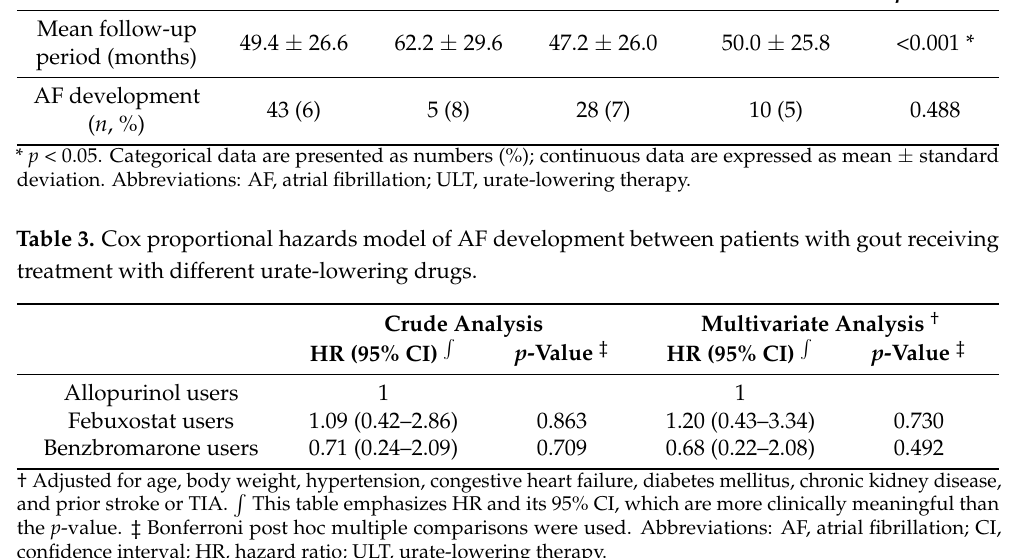
All ULT Allopurinol Febuxostat Benzbromarone Users Users Users Users